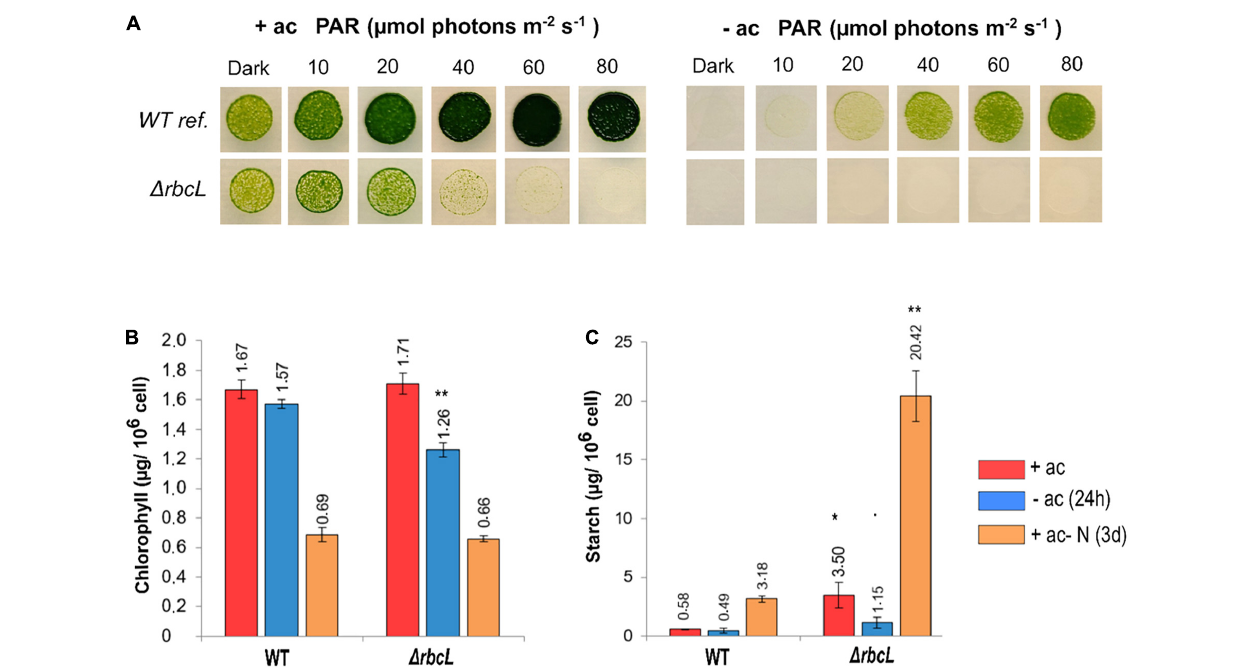
FIGURE 1 | Characteristics of the RuBisCO knockout strain (cid:49) rbcL. (A) Spot test to compare growth and photosensitivity of WT and (cid:49) rbcL on agar plates with (+ac) or without (–ac) acetate at six increasing light intensities. (B) Total chlorophyll content and (C) Starch accumulation under different conditions for WT and (cid:49) rbcL in low light (10 µ mol photons m − 2 s − 1 ), grown with acetate, without acetate during 24 h, or with acetate but in absence of nitrogen during 3 days. Biological replicates ( n = 3) with standard error. Pairwise t -test were performed between WT and (cid:49) rbcL (one dot, p < 0.1; one asterisk, p < 0.05; two asterisks, p <